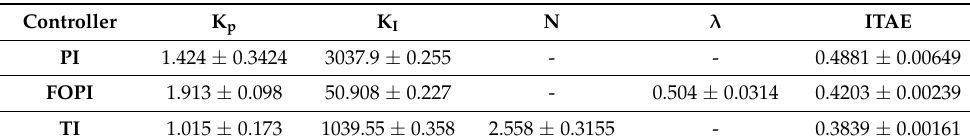
Table 3. The mean and standard deviation for the optimally tuned controller parameters and the ITAE value for the PI, FOPI, and TI controllers.